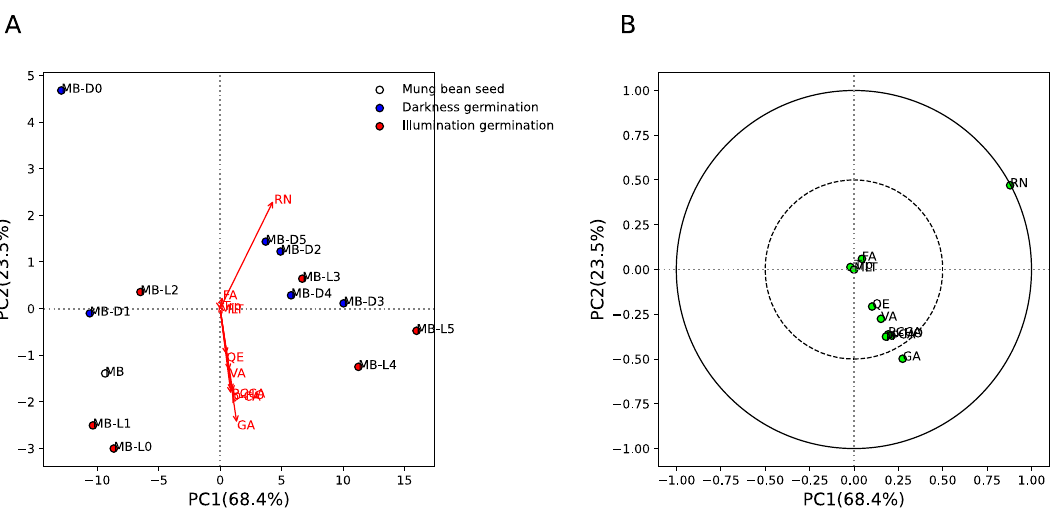
Figure 4. Principal componence analysis (PCA) of phytochemical components between mung bean seeds and sprouts germinated in darkness (0/24 h; MB-D0 to MB-D5) and illumination (12 h/12 h; MB-L0 to MB-L5) for 5 days. ( A ) Score plot of MB, MB-D0 to MB-D5, and MB-L0 to MB-L5. White, blue, and red colors indicate MB, MB-D, and MB-L, respectively. Red arrow indicates the phytochemical components of MB, MB-D0 to MB-D5, and MB-L0 to MB-L5. ( B ) Loading plot of phytochemical components of MB, MB-D0 to MB-D5, and MB-L0 to MB-L5. Green circles indicate the phytochemical components of MB, MB-D0 to MB-D5, and MB-L0 to MB-L5. Dashed and solid lines indicate correlation >0.5 and 1, respectively.